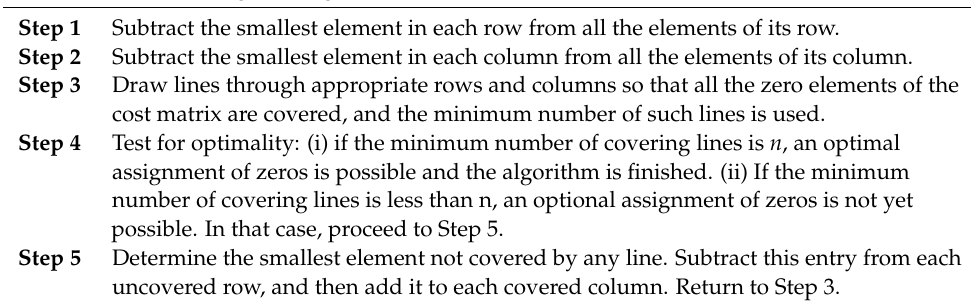
Algorithm 2 The Hungarian algorithm for task